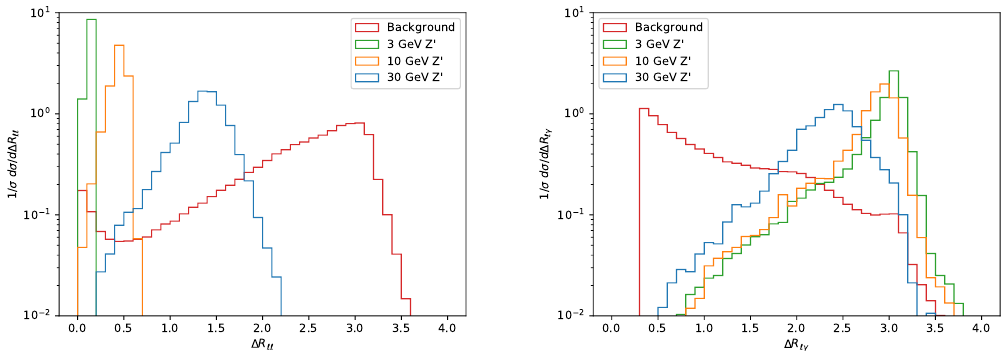
Figure 2 . The separation (cid:1) R between the leptons (left) and between the photon and the nearest lepton (right) as a function of the Z 0 mass in the signal events, compared to the background. All the distributions are